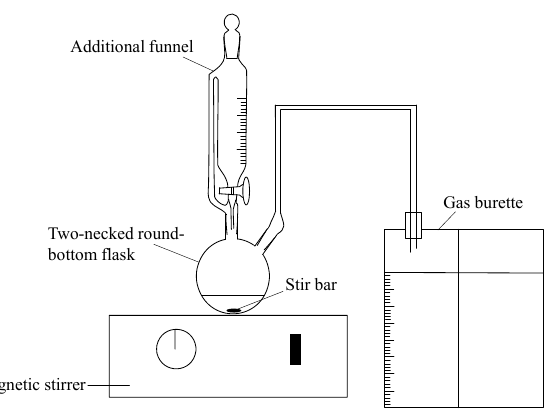
Fig. 2 Schematic illustration of the hydrolytic dehydrogenation of NH 3 BH 3 .